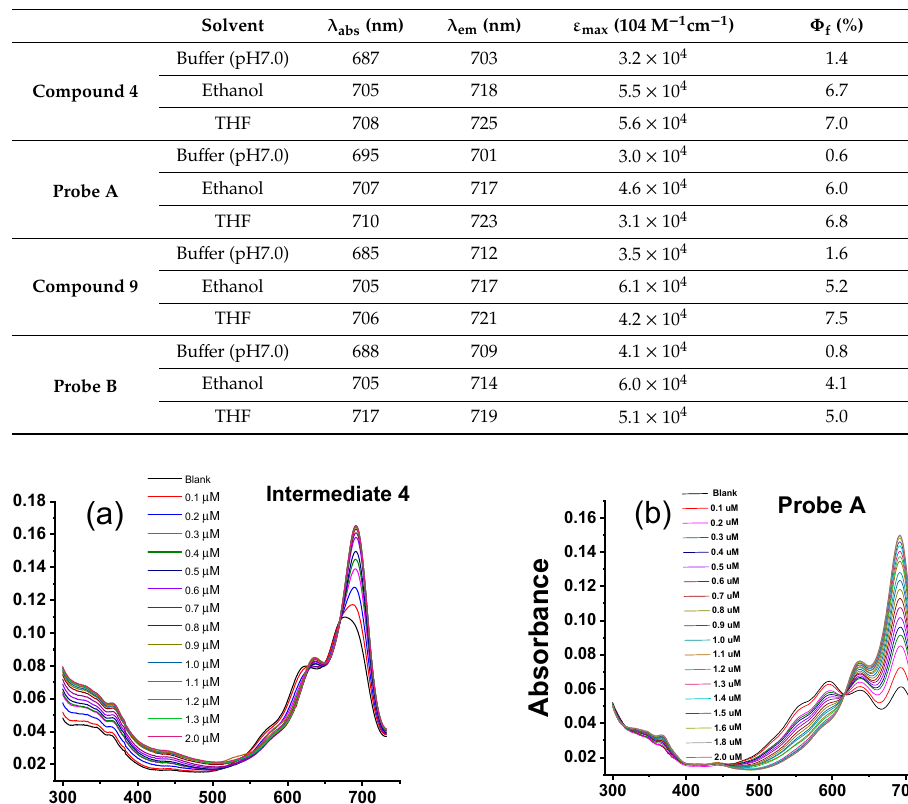
Table 1. Optical properties of intermediates and fluorescent probes A and B .